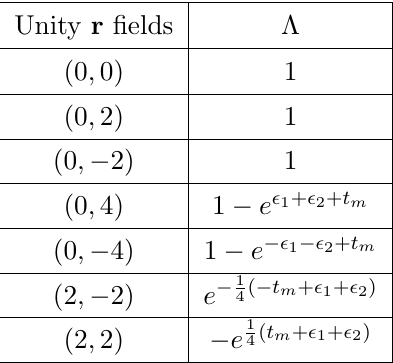
Table 1 . The non-equivalent unity r (cid:12)elds and (cid:3) of local F